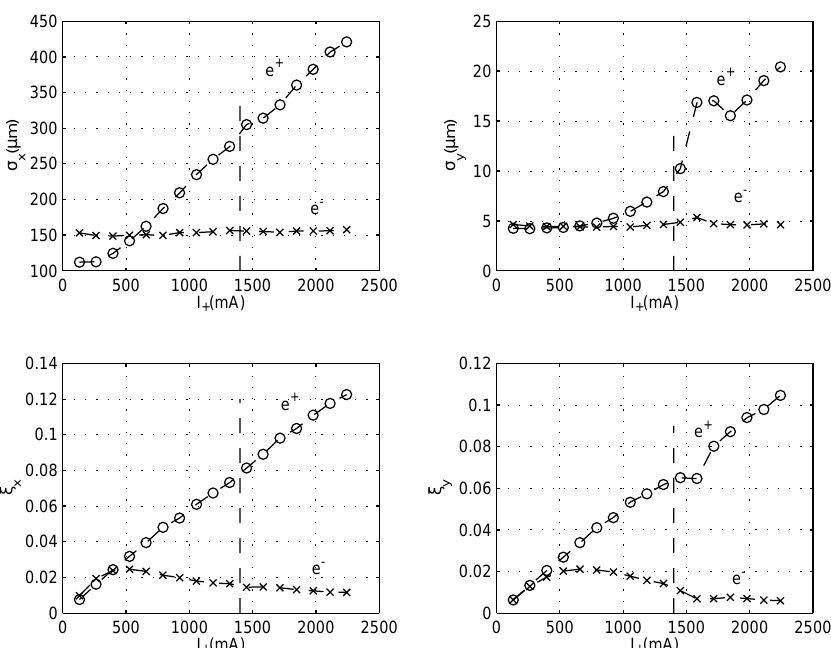
FIG. 3. The beam size and beam-beam tune shifts as a function of the positron current while the electron current is fixed at one-half of the positron current. The dashed line presents the maximum operating current of the positron beam with 605 bunches at 1400